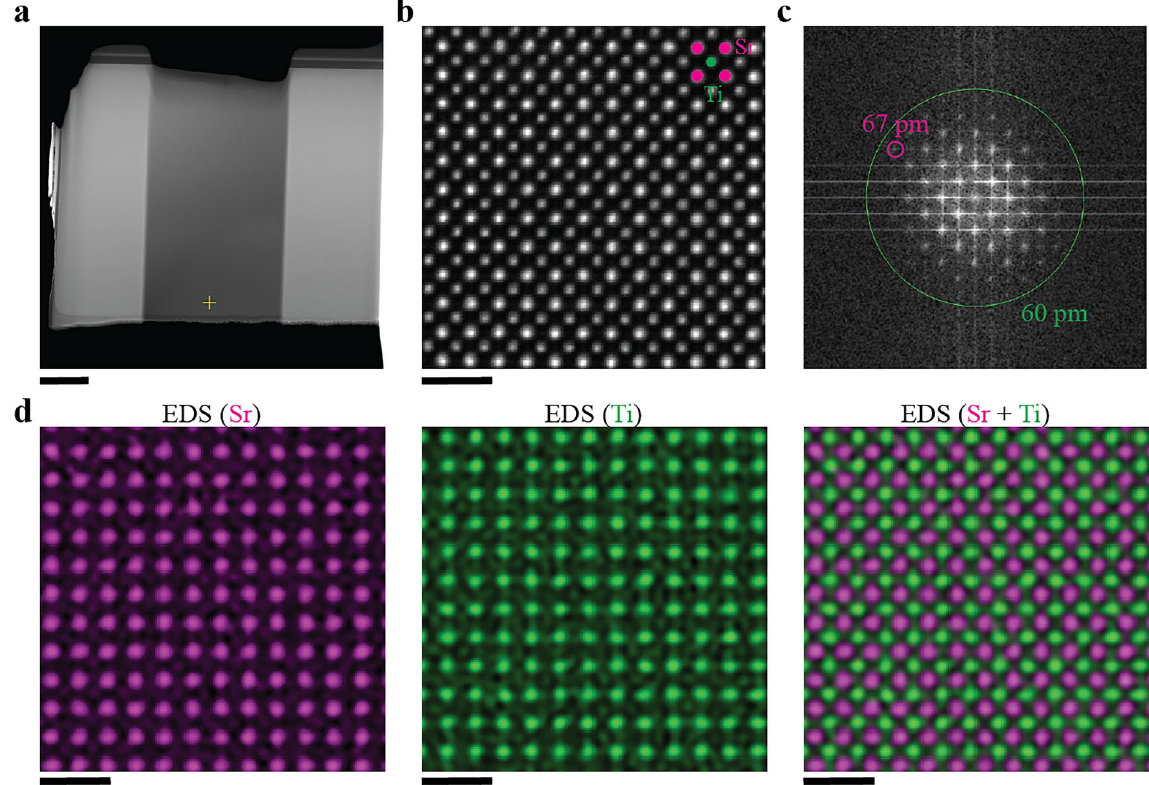
Figure 6. Aberration-corrected STEM results of a robotically prepared SrTiO 3 lamella. ( a ) A HAADF-STEM image of the entire SrTiO 3 lamella. ( b ) An atomic-level HAADF-STEM image along the [100] direction. The image was acquired near the thin bottom edge of the SrTiO 3 lamella (marked + in ( a )). ( c ) FFT pattern of ( b ). The magenta circle indicates an FFT reflection at 67 pm resolution. ( d ) Atomic-level EDS maps for Sr (left), Ti (center), and Sr combined with Ti (right). The scale bar in ( a ) is 1 μm, that in ( b,d ) is 1 nm.